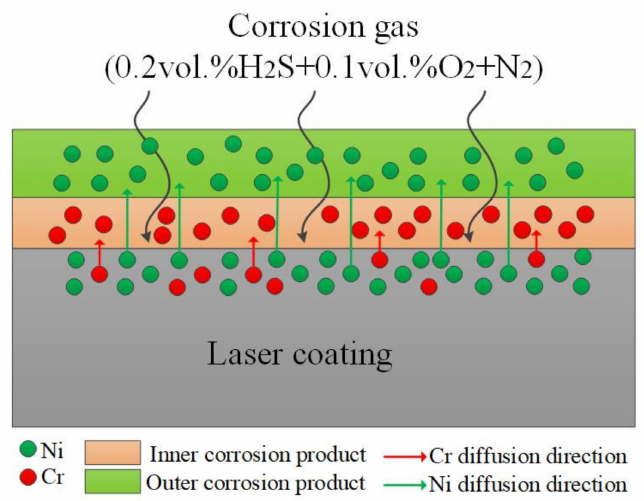
Figure 17. Corrosion principle, diagram of the cladding